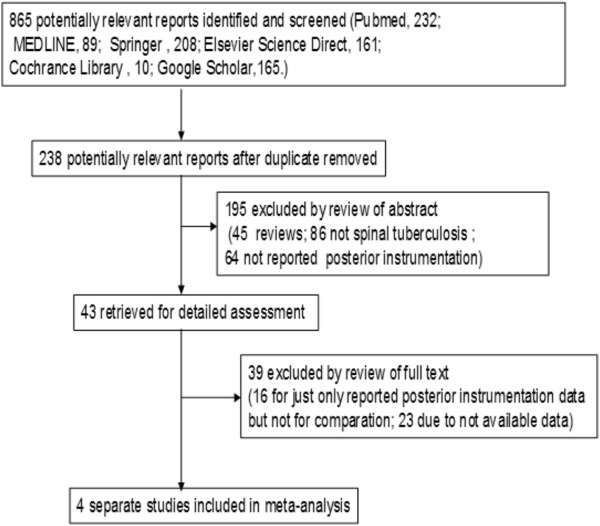
Flow diagram for selection of studies and specific reasons for exclusion from the meta-analysis.